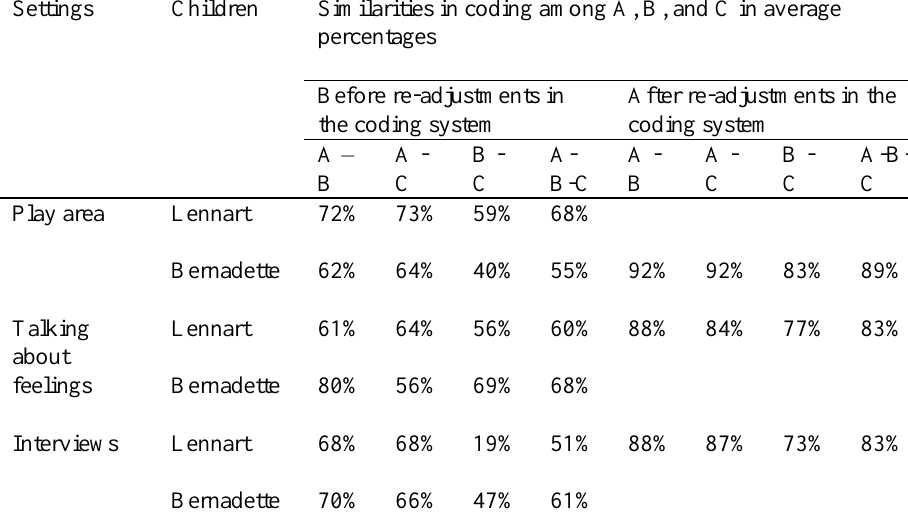
Comparison of the coding results among the researcher (A) and the coders (B and